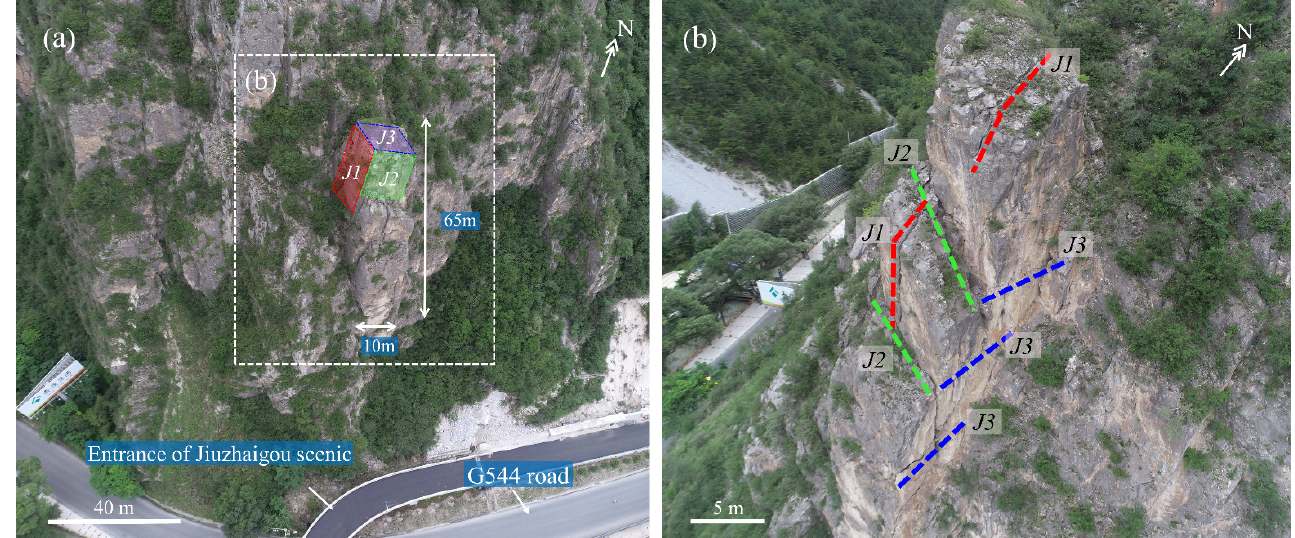
Figure 3. ( a ) The existence of three discontinuity sets that intersect with the slope face to form dan- gerous rock mass; ( b ) details of the in situ rock structures’ control of the slope